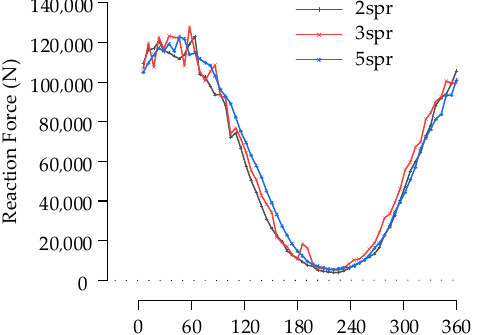
Figure 22. Equivalent roller load distribution of bearing 1 under different cases.